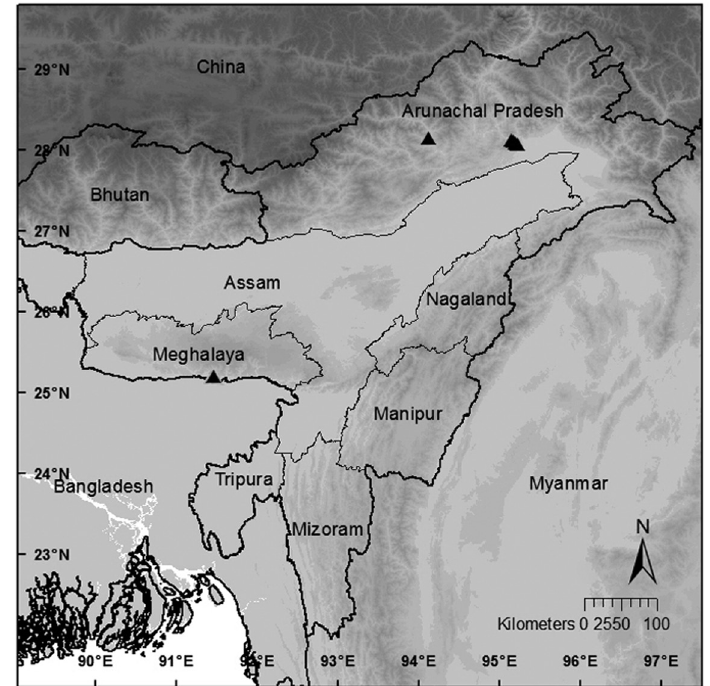
Fig. 54. Map showing the location of B. scintillans